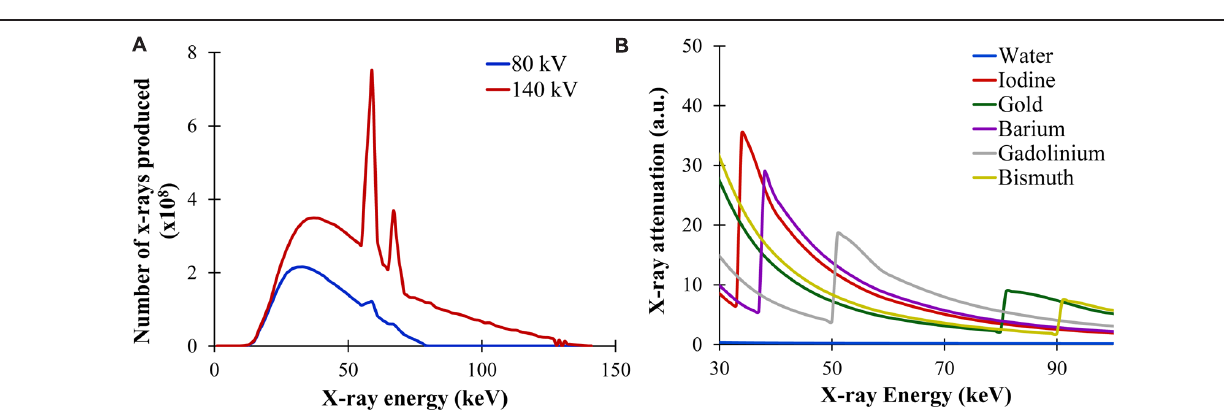
FIGURE 2 | X-ray production and attenuation. (A) X-ray energy spectra produced at two different tube voltages: 80 and 140 kV. Both the number of photons produced and the mean energy of the spectrum increases with higher voltage. (B) X-ray attenuation as a function of x-ray energy for multiple materials. In general, the x-ray attenuation rapidly drops with increasing x-ray energy. At the K-edge of each material, there is a sharp rise in attenuation due to the photoelectric absorption at that